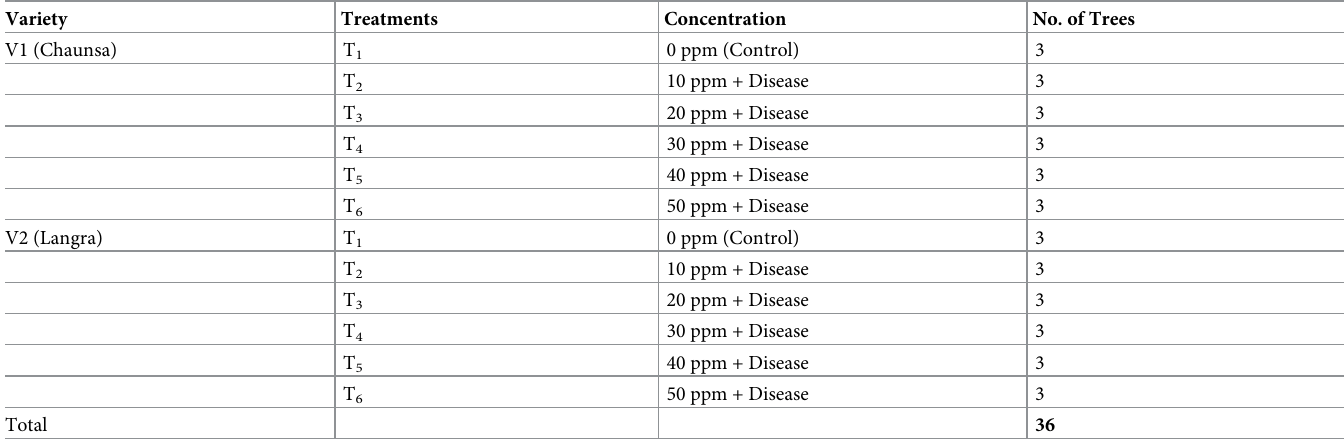
Table 1. Experimental